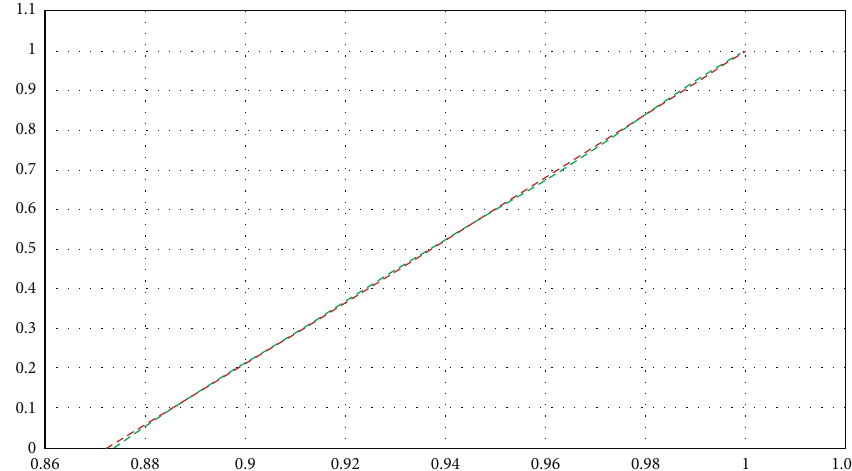
Figure 4: Comparison of the confidence level of the actual answer and the approximate solution for Example 1. Red color indicates confidence level in exact solution, and green color indicates confidence level in approximate solution.